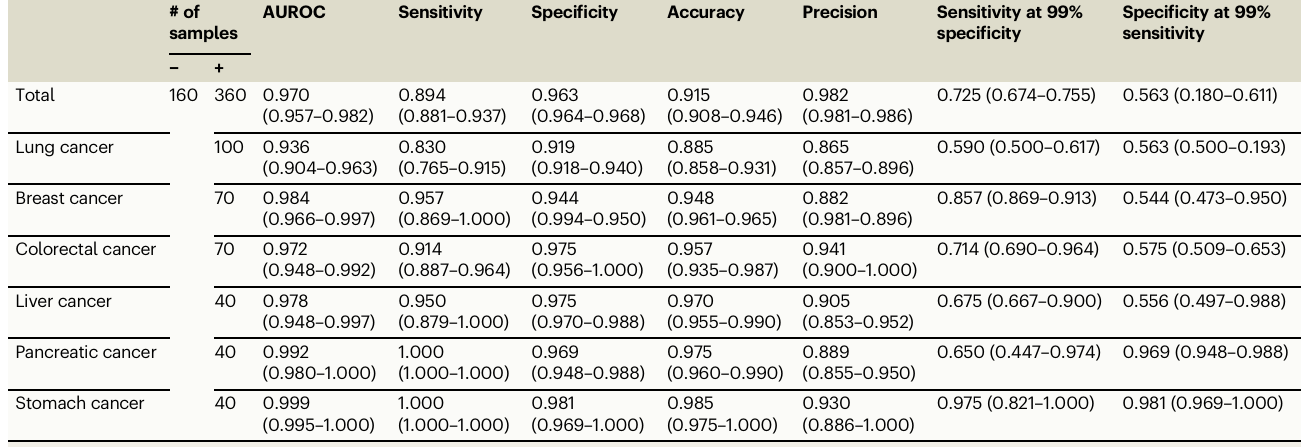
Table 1 | Binary diagnostic performance for cancer presence for test